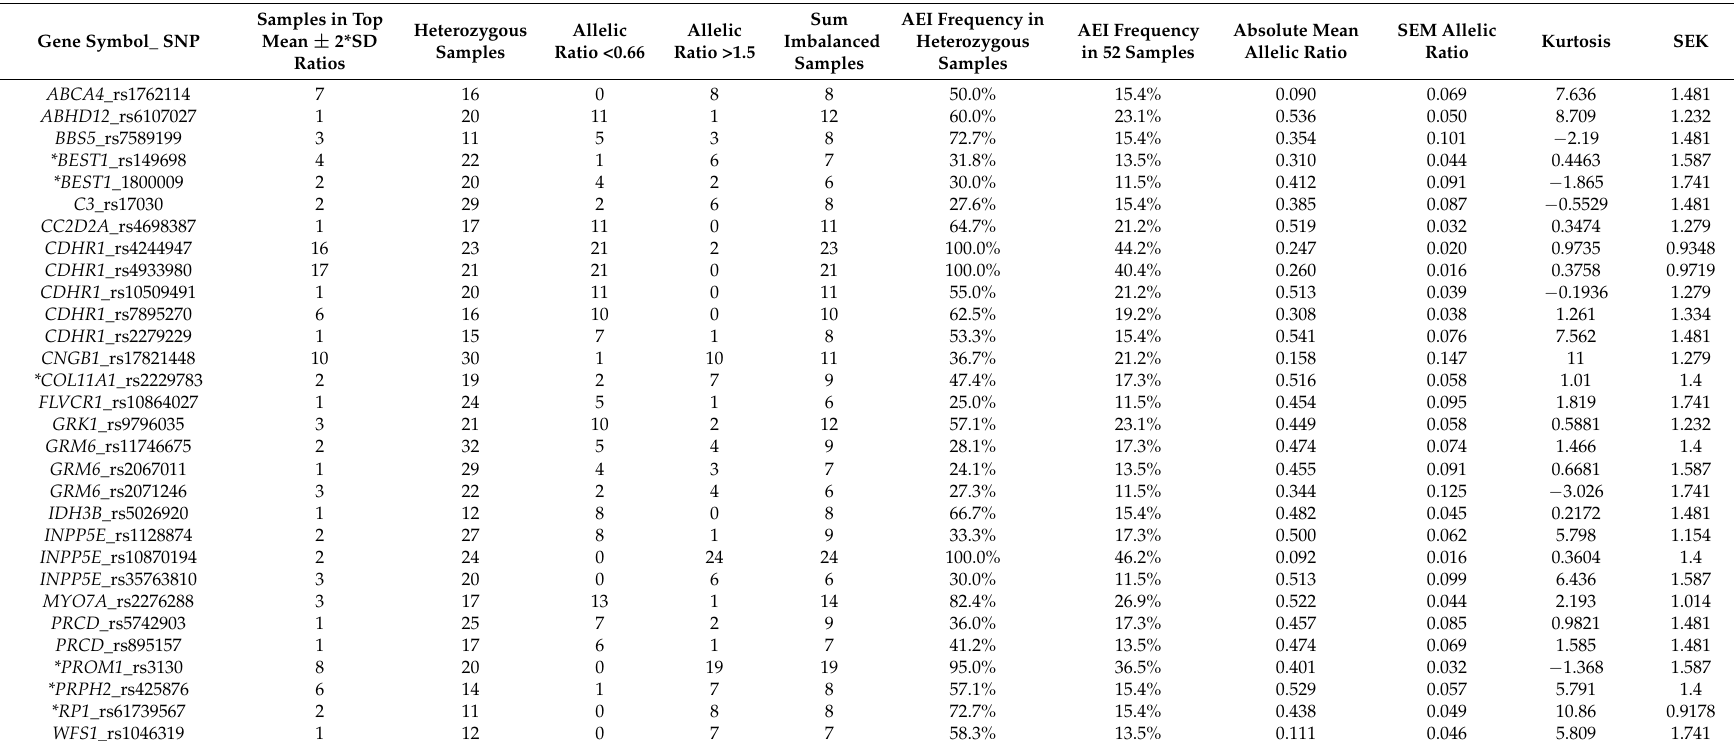
Table 1. SNPs in inherited retinal diseases (IRD) genes displaying allelic expression imbalance (AEI) frequencies higher than 10% in the 52 RNA-seq dataset. Highlighted with an asterisk are those genes known to be associated with autosomal dominant IRD. Kurtosis was estimated to stress those SNPs where imbalance was consistent with a single molecular cause (kurtosis ≥ 3 indicates closer distribution of the data points towards the mean; standard error of kurtosis is provided as SEK). Standard error of the mean (SEM) of the allelic ratio was also